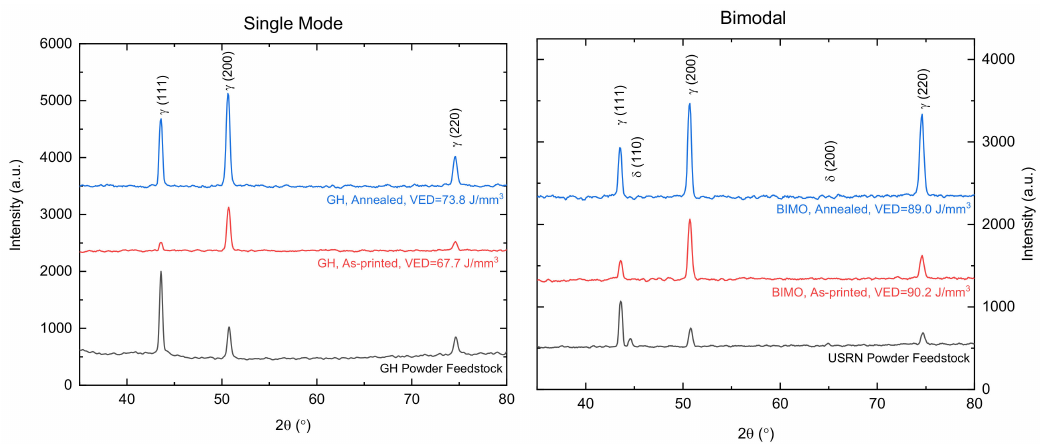
Figure 8. XRD pattern of GH large powder and BIMO bimodal powder, along with patterns of as-printed and annealed SLM-manufactured samples produced from each powder type at di ff erent VEDs, showing a primarily austenite phase for